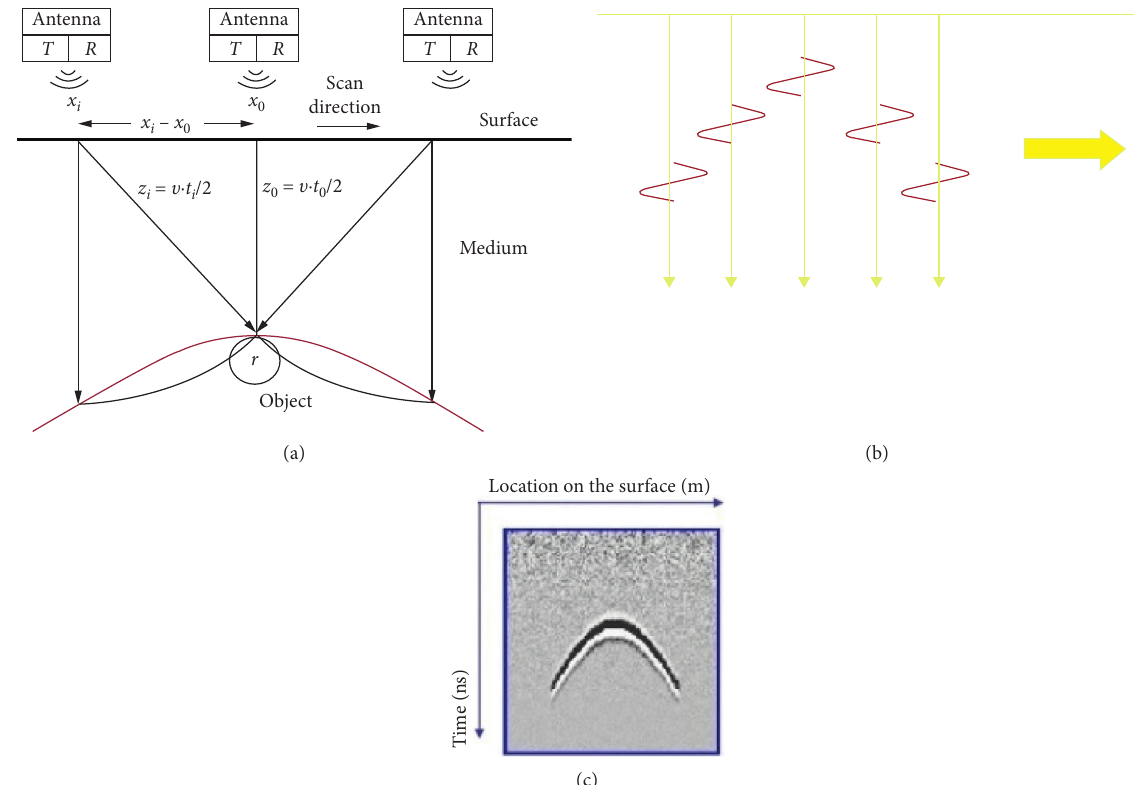
Figure 3: The formation of hyperbolic signature in the radar image. (a) Geometrical characteristics of a buried reinforcing bar in concrete, (b) radar wave traces, and (c) hyperbolic signature of the reinforcing bar.